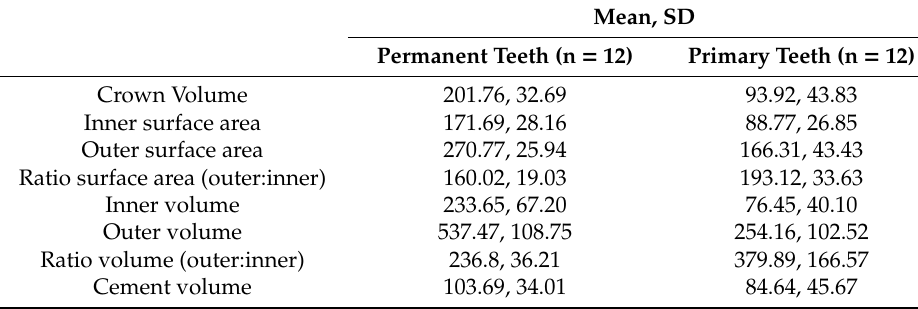
Table 1. Summary Statistics (mean, SD) for Permanent and Primary